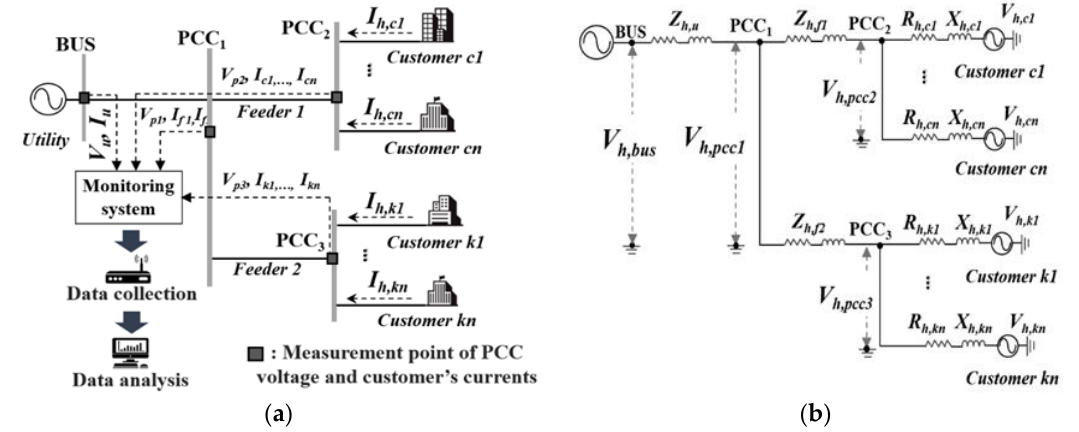
Figure 1. An example of a distribution network. ( a ) Data measurement. ( b ) The network’s equivalent harmonic voltage model.